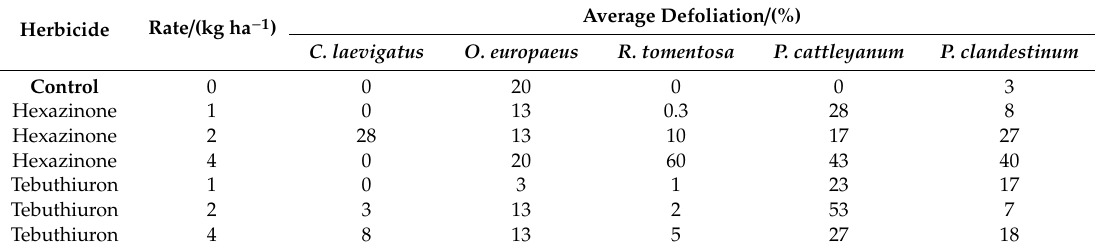
Table 2. Response of karaka nut tree ( Corynocarpus laevigatus ), wild olive tree ( Olea europaeus ), rose myrtle ( Rhodomyrtus tomentosa ), strawberry guava ( Psidium cattleyanum ) and kikuyu grass (